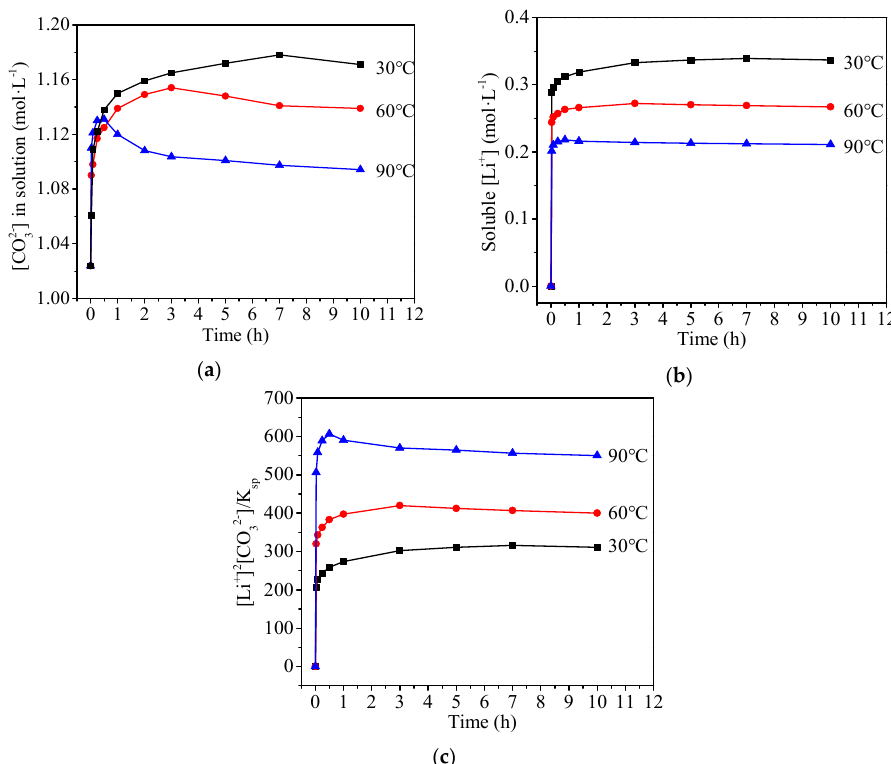
Figure 2. Variation of ( a ) soluble [Li + ], ( b ) [CO 32 − ] and ( c ) supersaturation with reaction time.